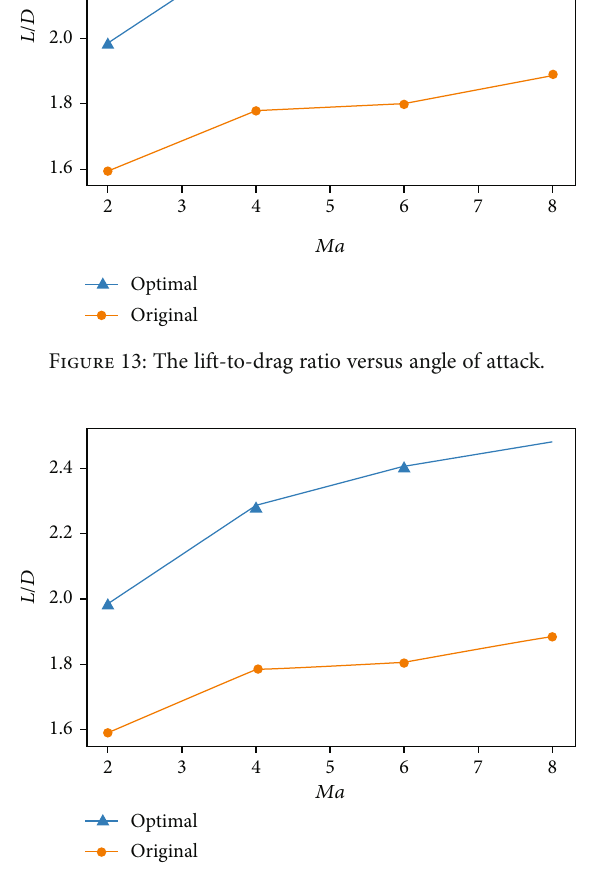
Figure 14: The lift-to-drag ratio verse Mach